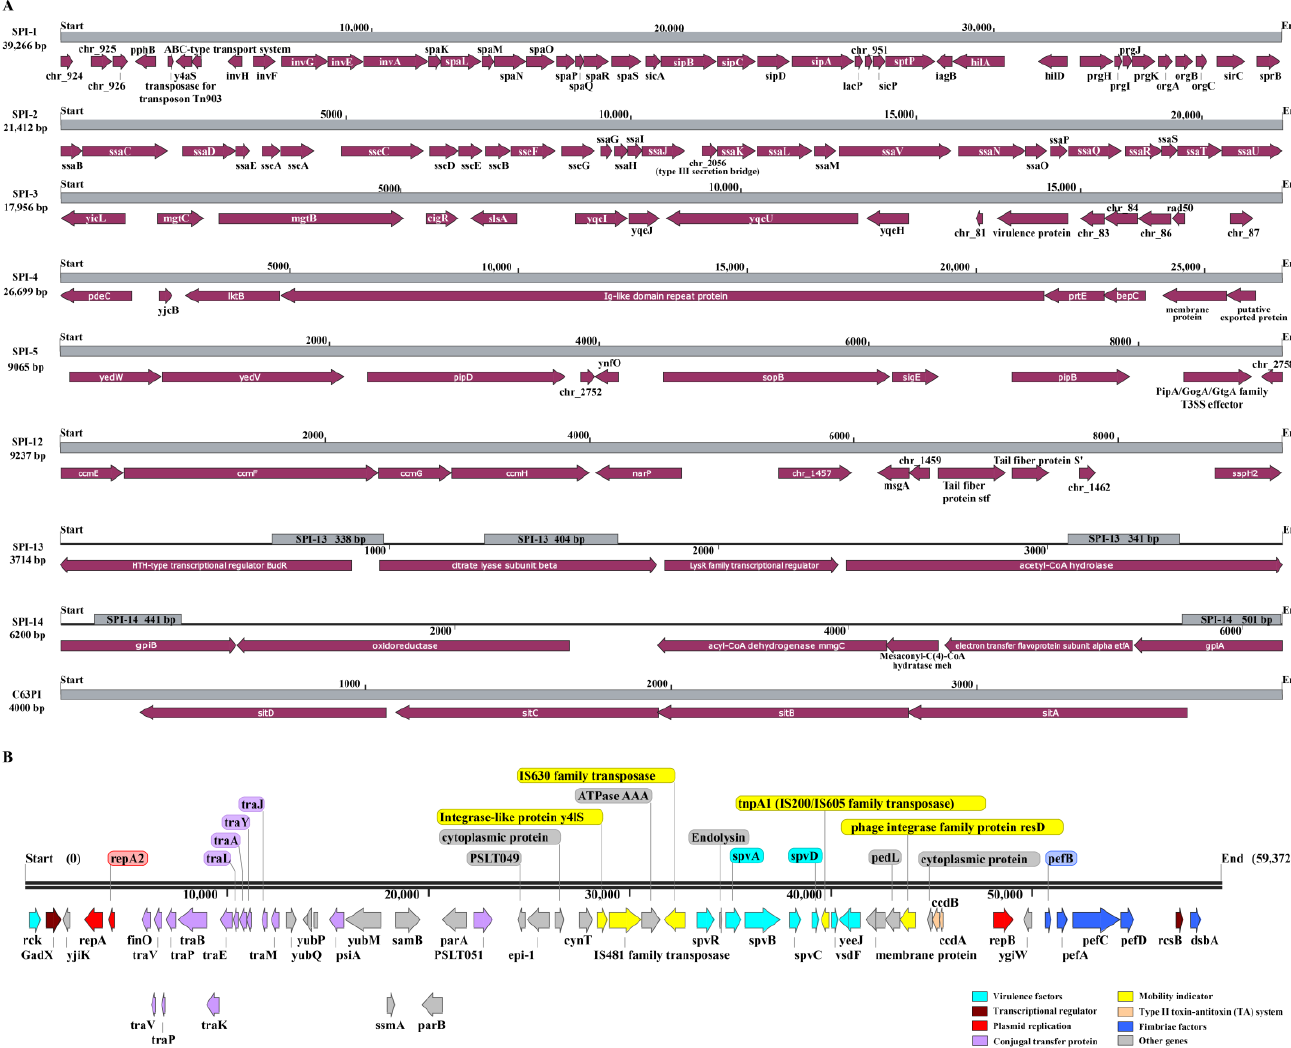
Figure 2. Detailed mapping Salmonella pathogenicity islands (SPIs) and plasmid in SE211 genome. ( A ) Schematic represen- tation of the genes carried within the nine SPIs predicated in the genome of SE211. The grey boxes represented the range of SPIs, and the brown boxes showed the CDS encoded in these SPIs regions. ( B ) Gene profile of the virulence plasmid in SE211. Different colors were indicating specific functions as shown at the bottom.3.4. Mobile Genetic Elements